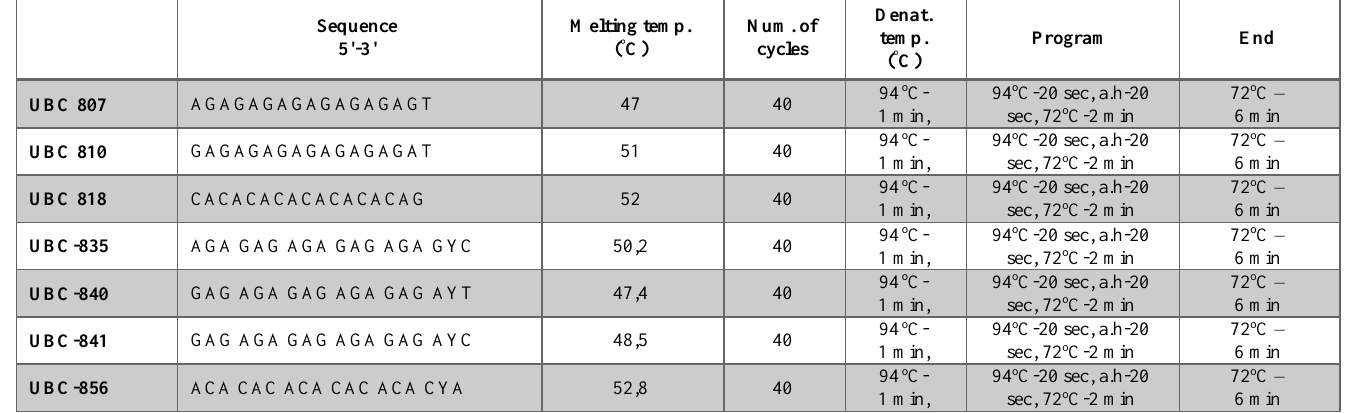
Table 1. The PCR circumstances and used ISSR primers